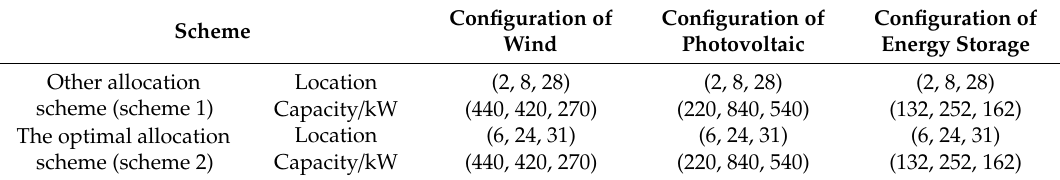
Table 2. Optimal allocation scheme of the distributed energy considering the dynamic